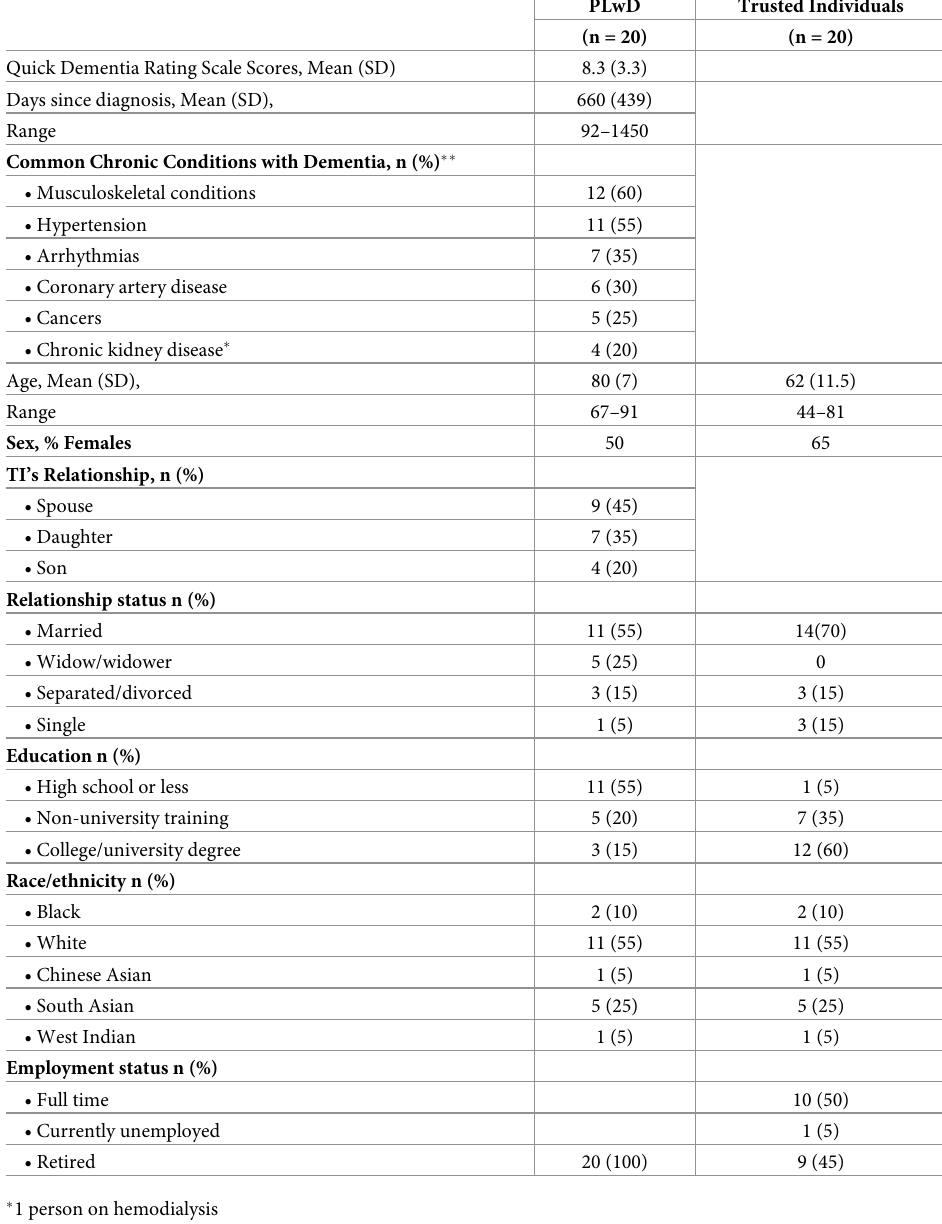
Table 1. Characteristics of